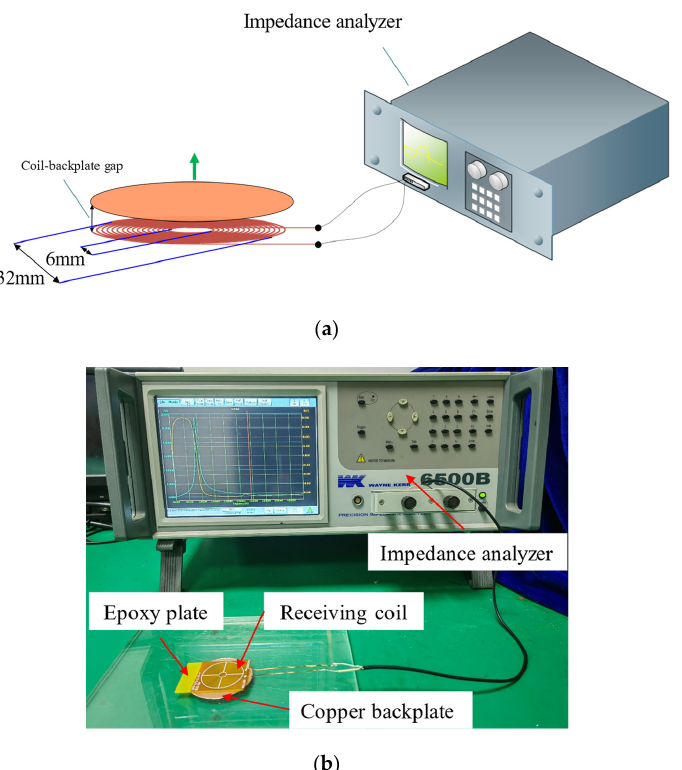
Figure 5. The impedance measurement platform. ( a ) Diagram of the experimental settings. ( b ) Photograph of the impedance measurement-platform.